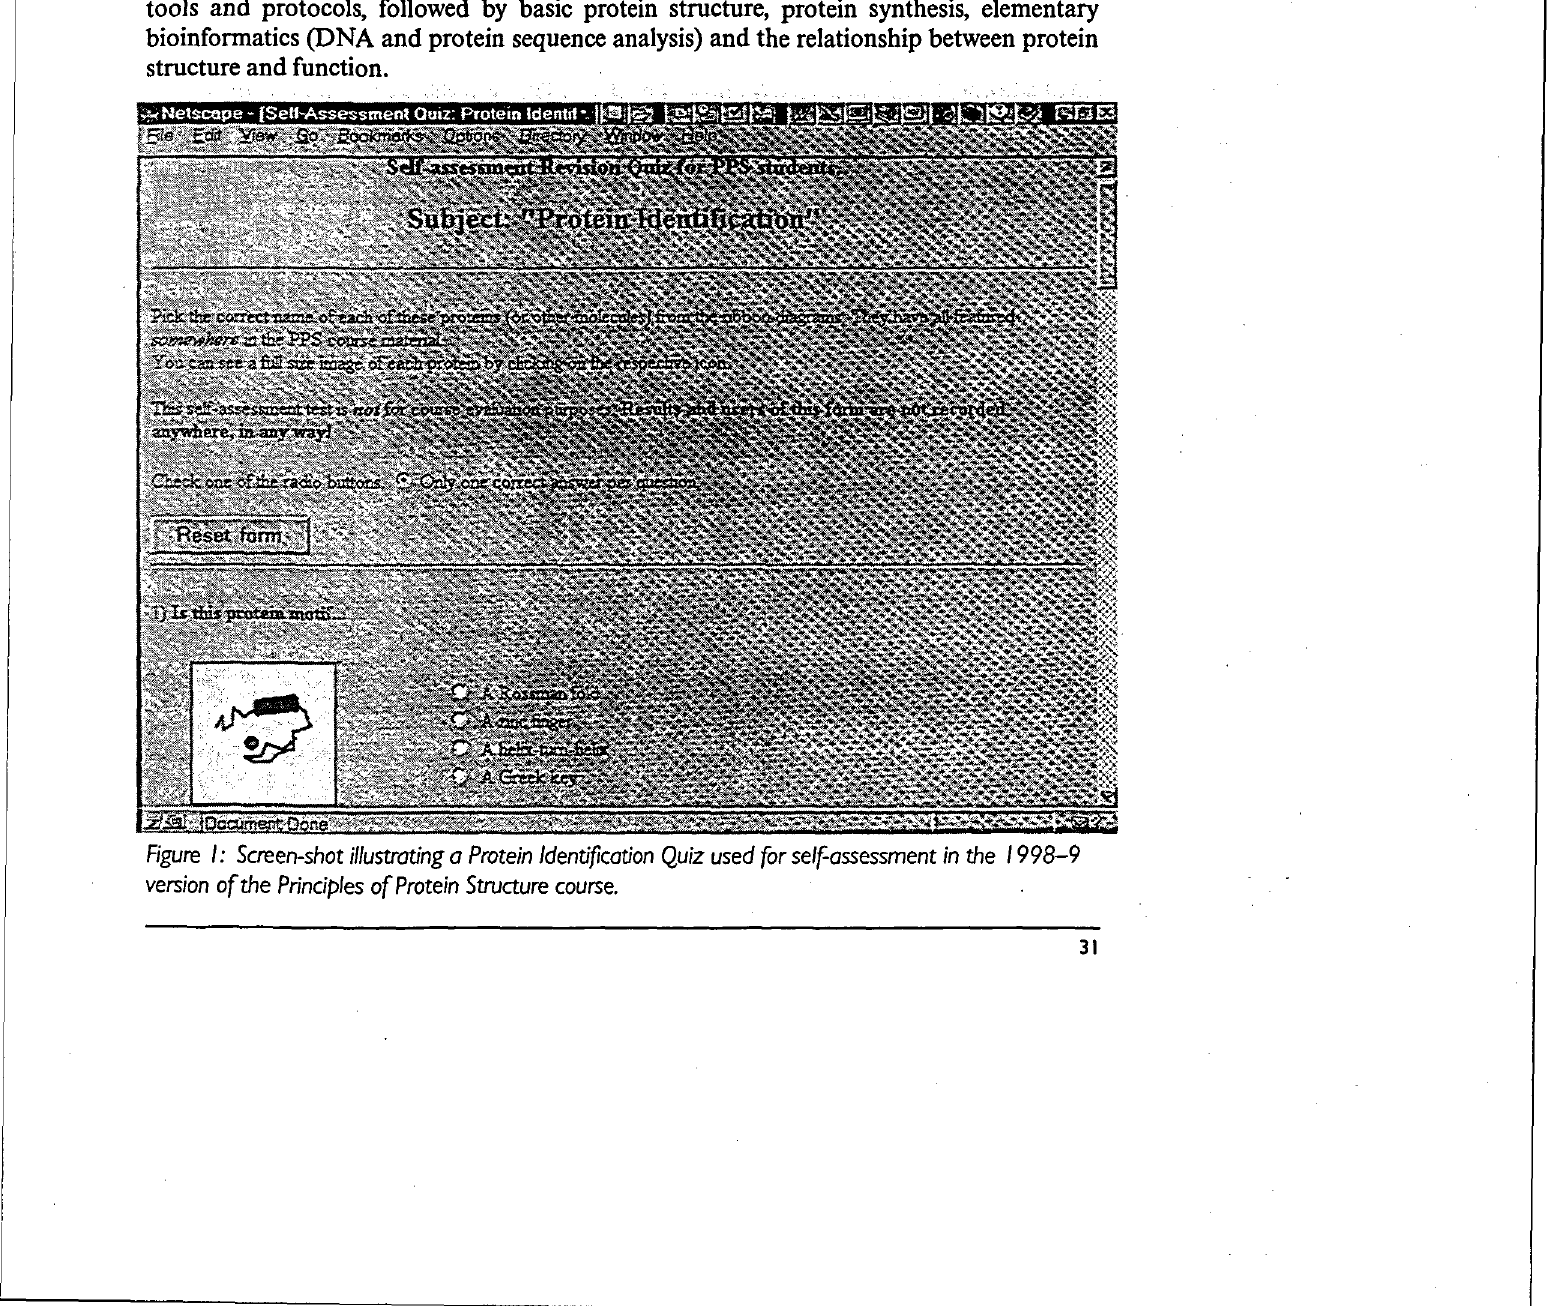
Figure I: Screen-shot illustrating a Protein Identification Quiz used for self-assessment in the 1 998-9 version of the Principles of Protein Structure